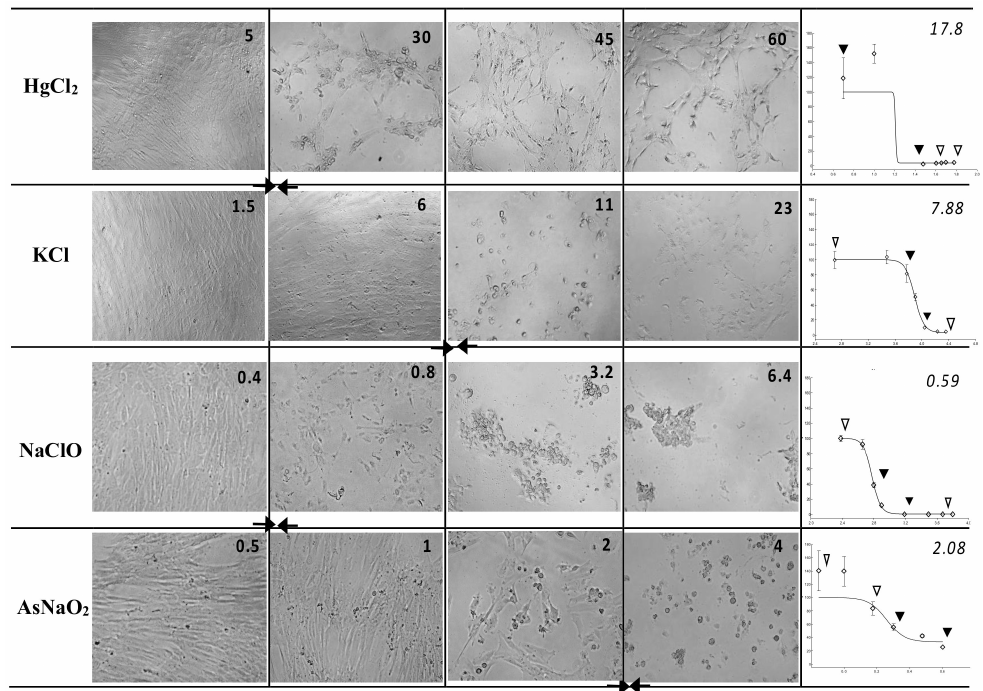
Figure 1. Cytotoxicity in WJSCs following 48 h of exposure to various concentrations of chemicals— Left panel: micrographs (25 × ) of WJSCs 48 h after exposure to four chemicals representative of four hazard classes; the four concentrations are shown from highest (far right) to lowest (leftmost column). Figure inserts in top right corner of each micrograph denote the exact concentration (in ug/mL) of the chemical used. Right panel: respective survival curves (y = % viability, x = concentration in log ug/mL) for each chemical and their IC 50 values (ug/mL; top right corner of plots). Arrows on survival curves depict the four respective concentrations shown on the micrographs on the left. Diamonds depict all tested concentrations. IC 50 values correspond to the curve area between the two solid arrowheads and the culture status delineated by the micrographs marked by two solid arrows in the left